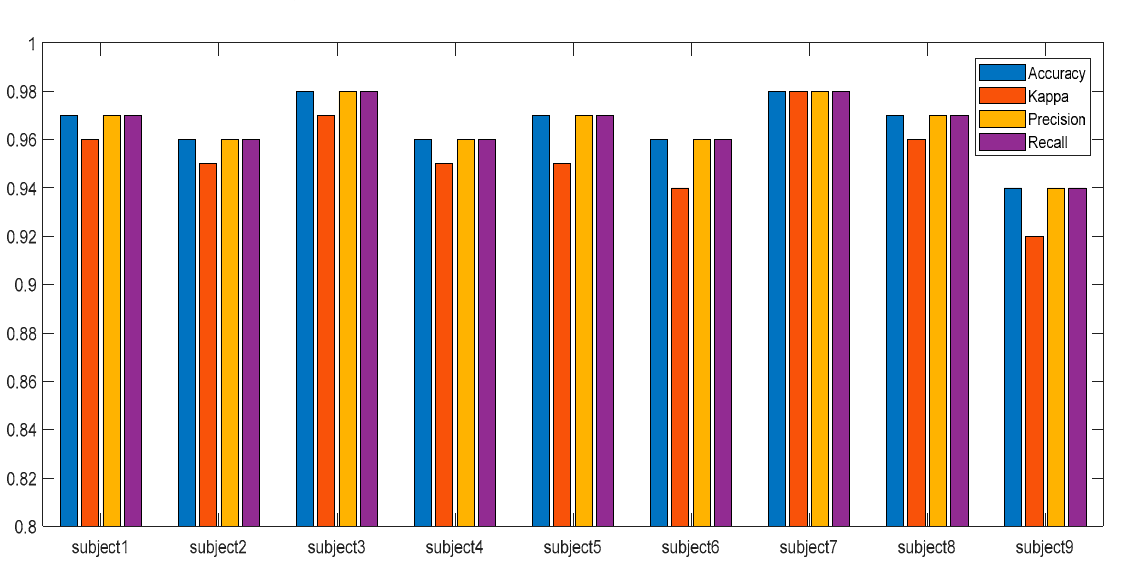
Figure 5. Kappa value according to window size.